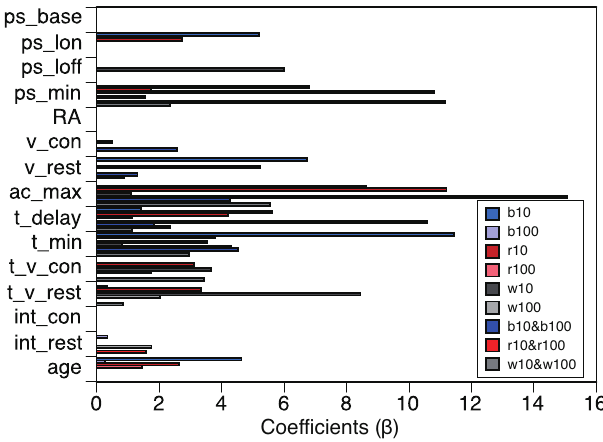
Figure 7. Comparison of coefficients of features using prediction functions